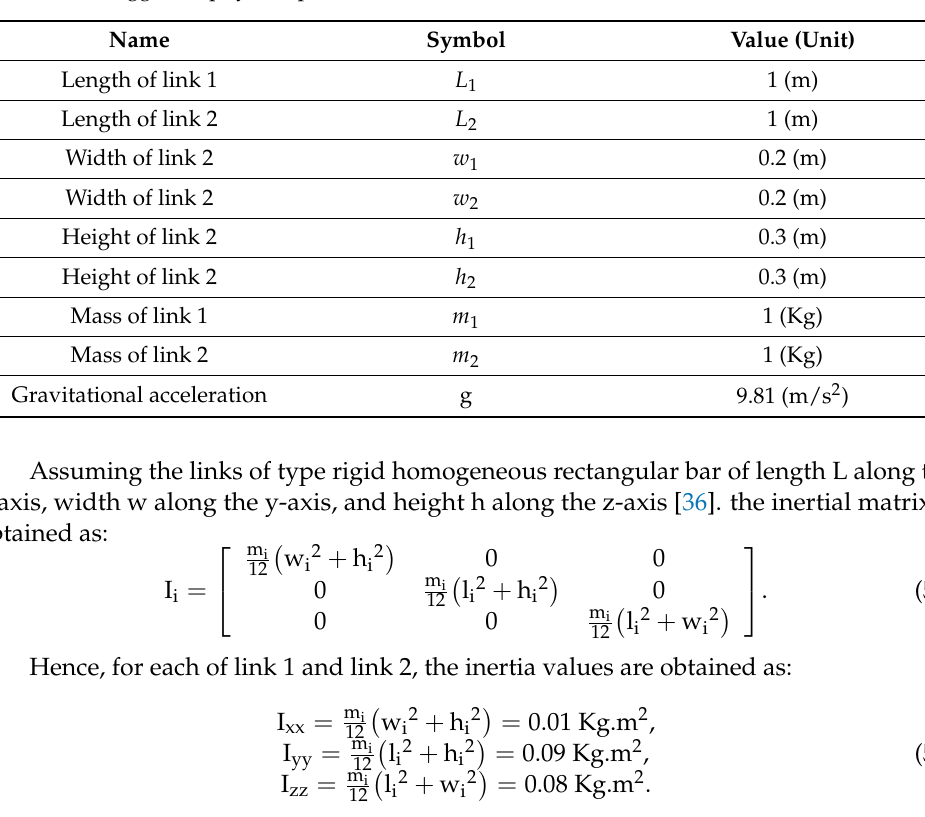
Table 2. The suggested physical parameters of